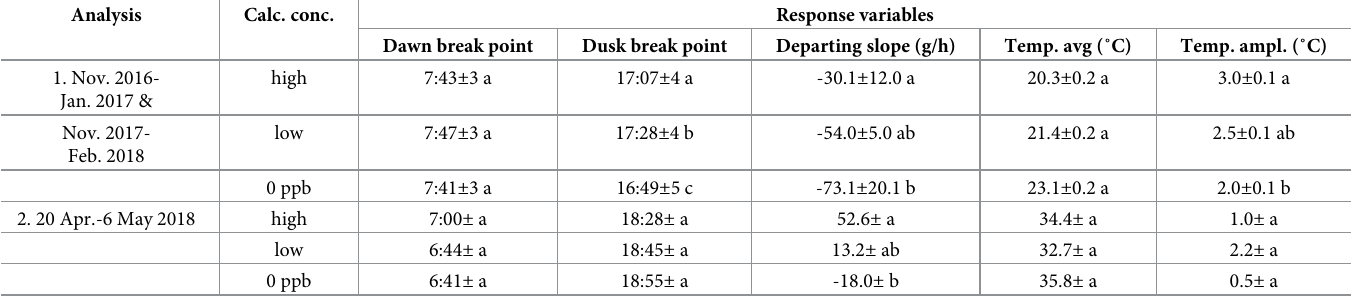
Table 2. Results and treatment means of post hoc comparisons for three response variables with significant treatment effects for 2 analyses conducted on three field experiments on the effects of sublethal methoxyfenozide exposure to honey bee colonies. Times shown are on a 24 h clock; calc. conc. = calculated concentration, temp = temperature; avg = average; ampl. = amplitude. Temperature data in Analysis 1 were restricted to after 30 November in both years. Analysis Calc. conc.